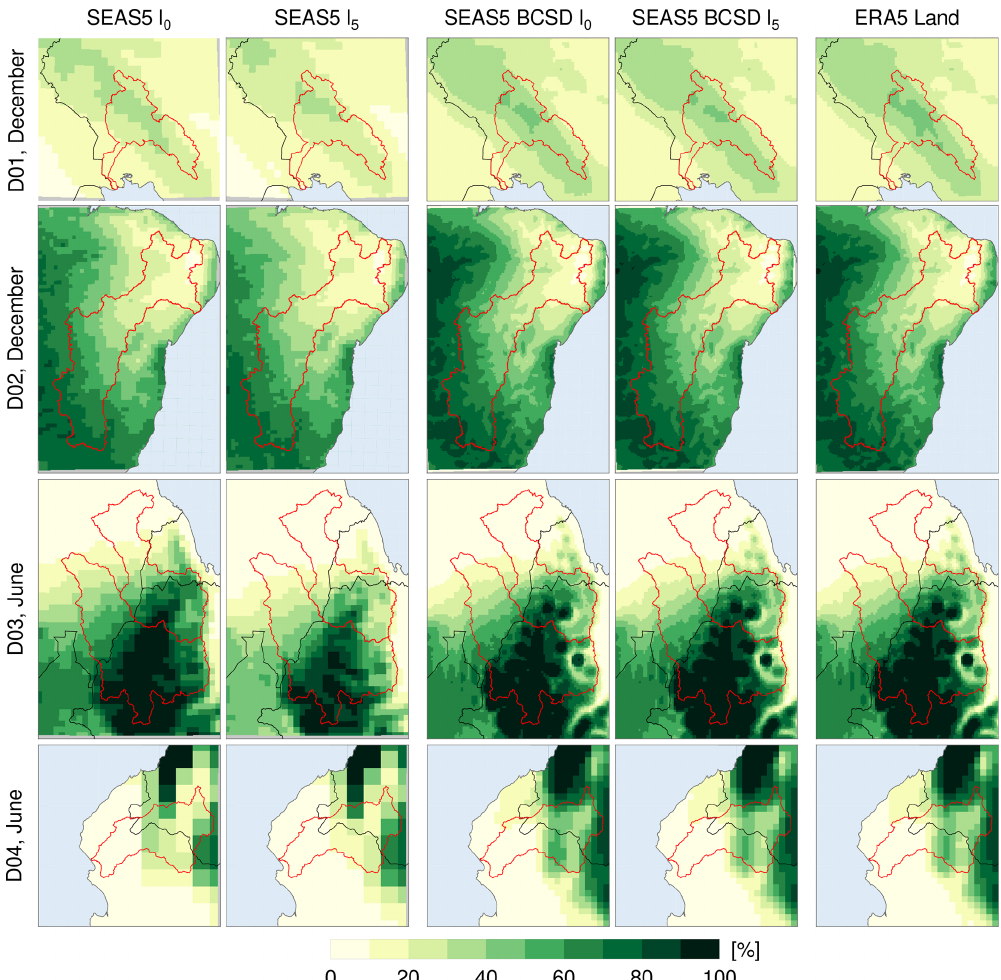
Figure 7. Wet-day ( > 1mm/d) probability for the four study domains for a single month (D01: December, D02: December, D03: June, D04: May) from SEAS5 and SEAS5 BCSD for both lead 0 and lead 5, respectively, and the reference